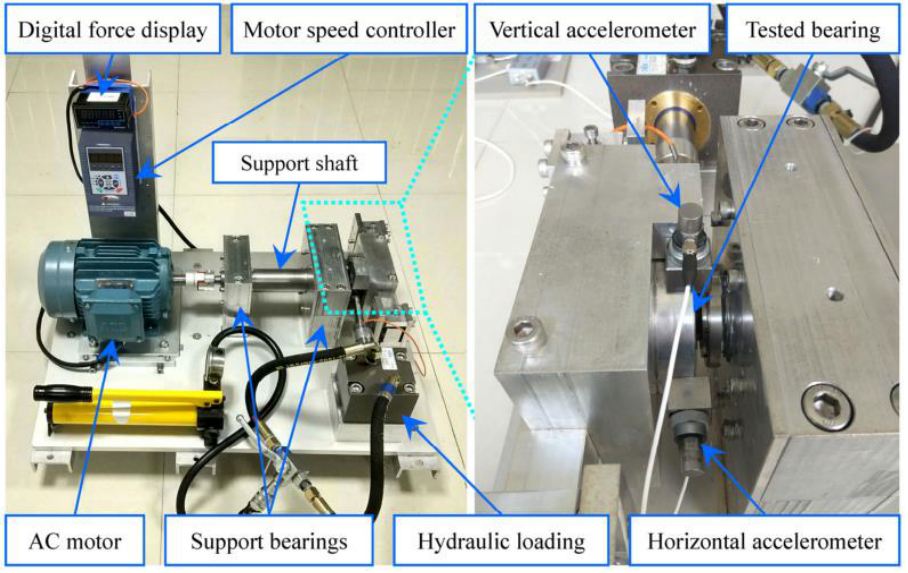
Figure 3. Testbed of rolling element bearings.